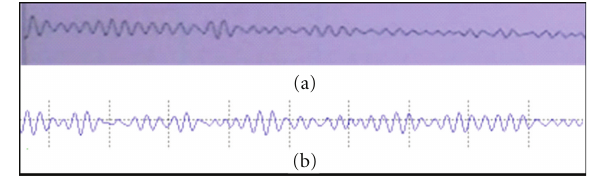
Figure 11: Wave measurement for eye-opening.